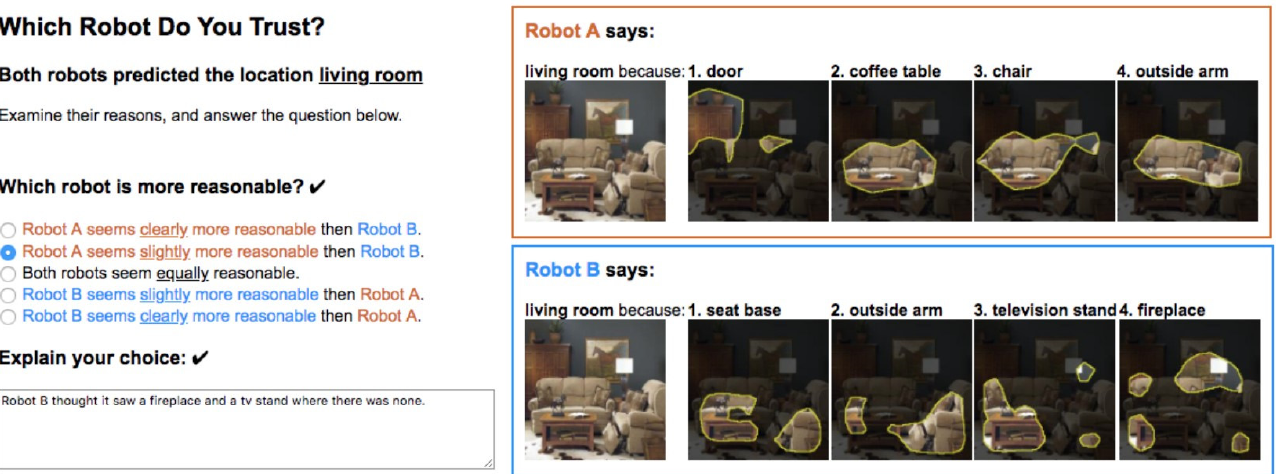
Figure 9. GraphXCovid pneumonia CXR results.